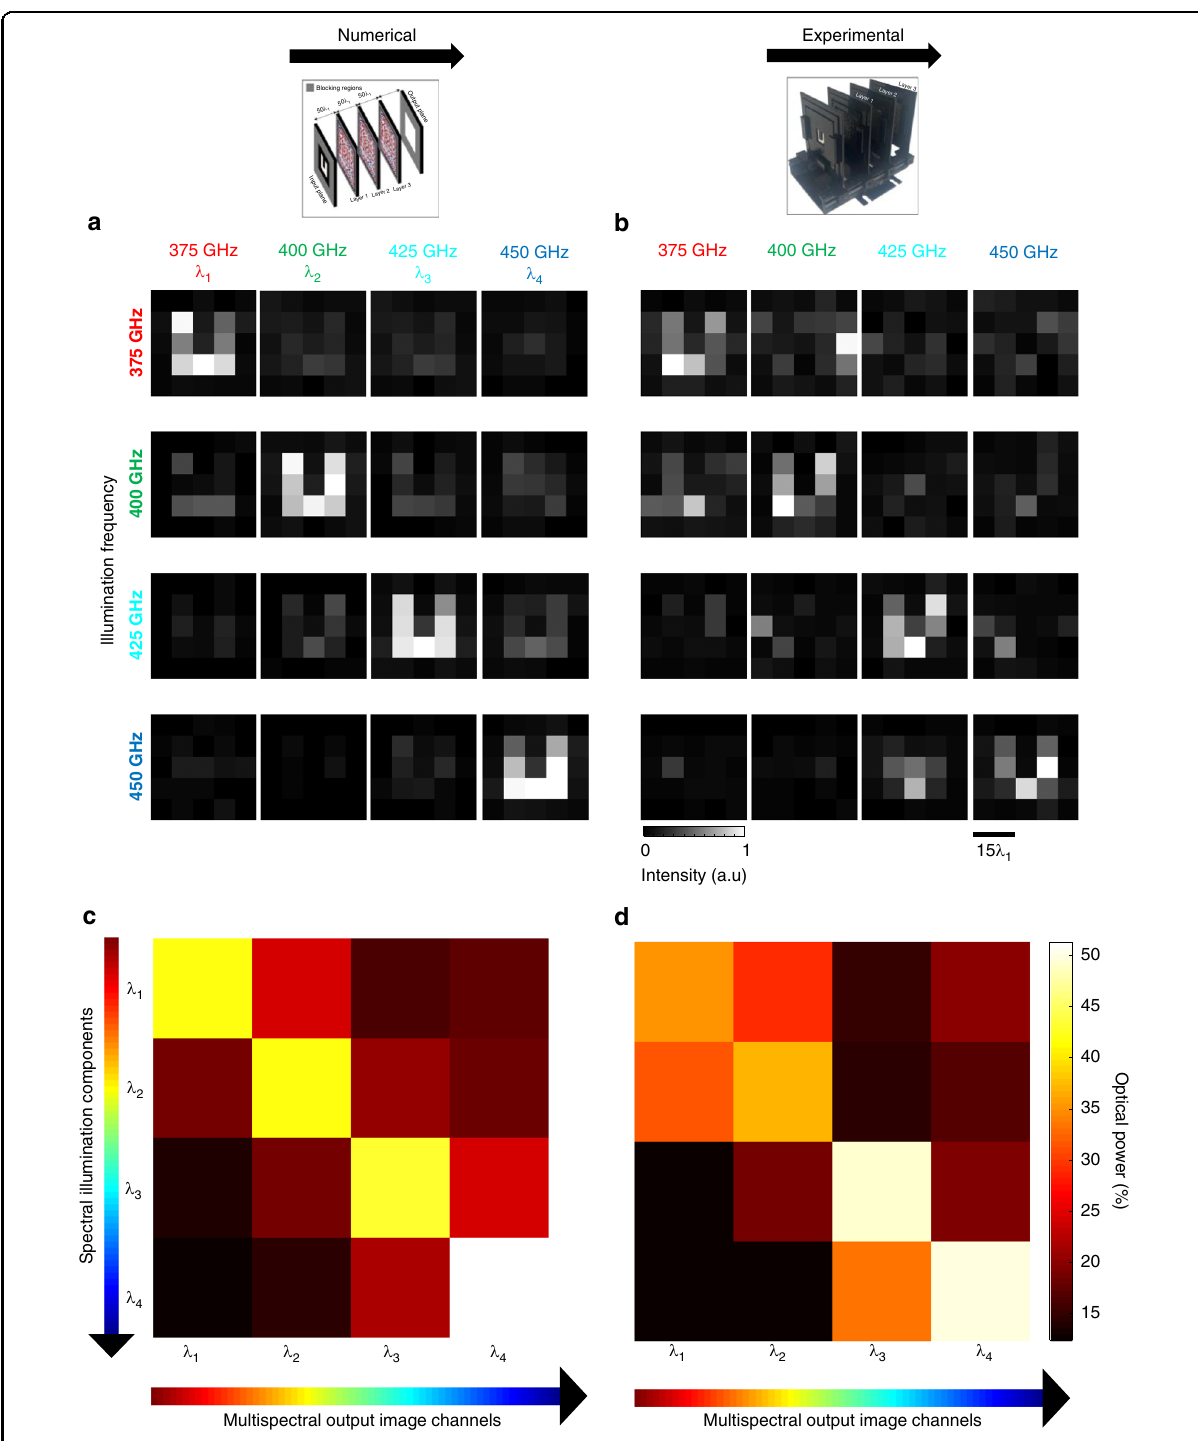
Fig. 7 Experimental results for the diffractive multispectral imager shown in Fig. 6. Multispectral imaging of letter ‘ U ’ at 4 distinct wavelengths in terahertz part of the spectrum based on the 3-layer diffractive optical network shown in Fig. 6. a Multispectral image cube synthesized by the numerical forward model of the diffractive optical network, after the demosaicing step. b Same as ( a ), except that the images are extracted from the experimentally measured output optical intensity pro fi les. c Cross-talk matrix predicted by the numerical forward model of the diffractive multispectral imager in response to the input object ‘ U ’ . d Same as ( c ), except that the entries in the cross-talk matrix represent the experimentally measured percentages of the optical power for each spectral